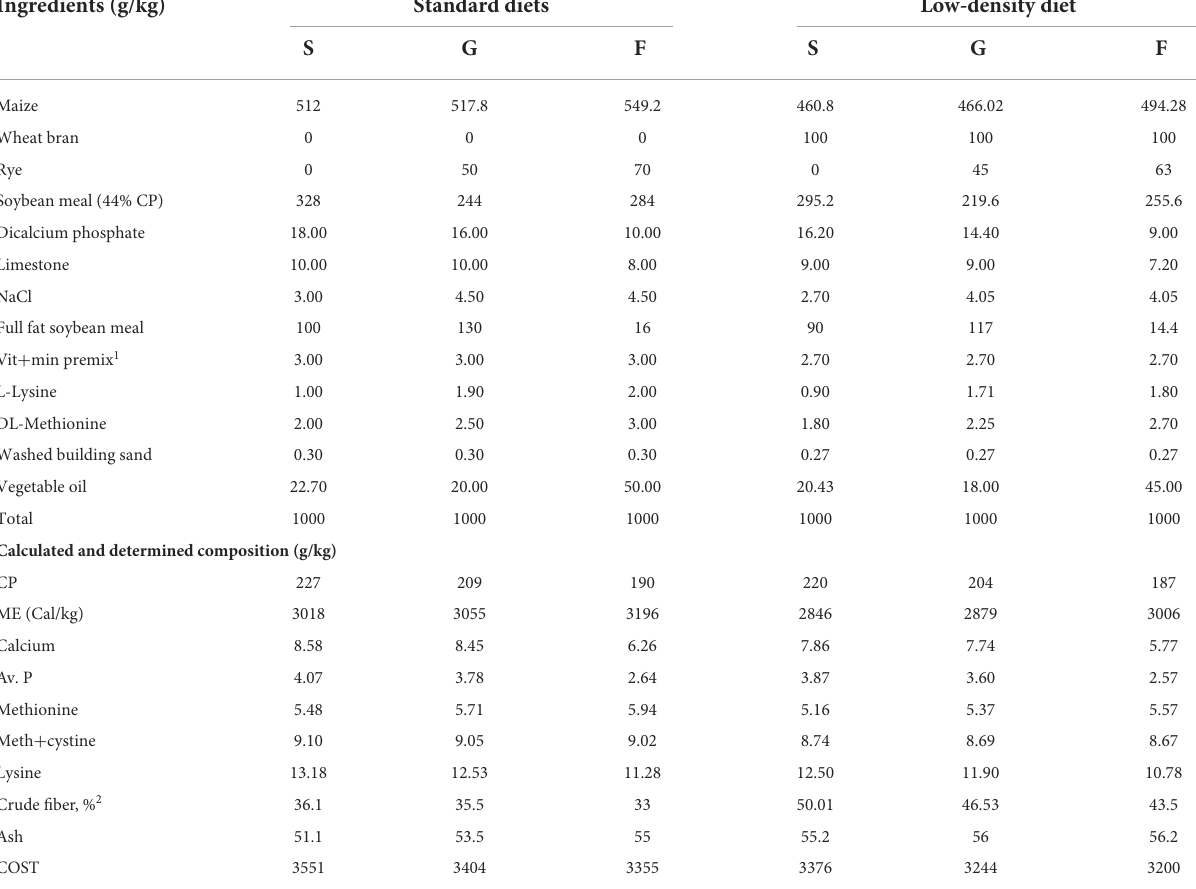
TABLE 1 Nutrient and chemical composition of the basal experimental diet. Ingredients